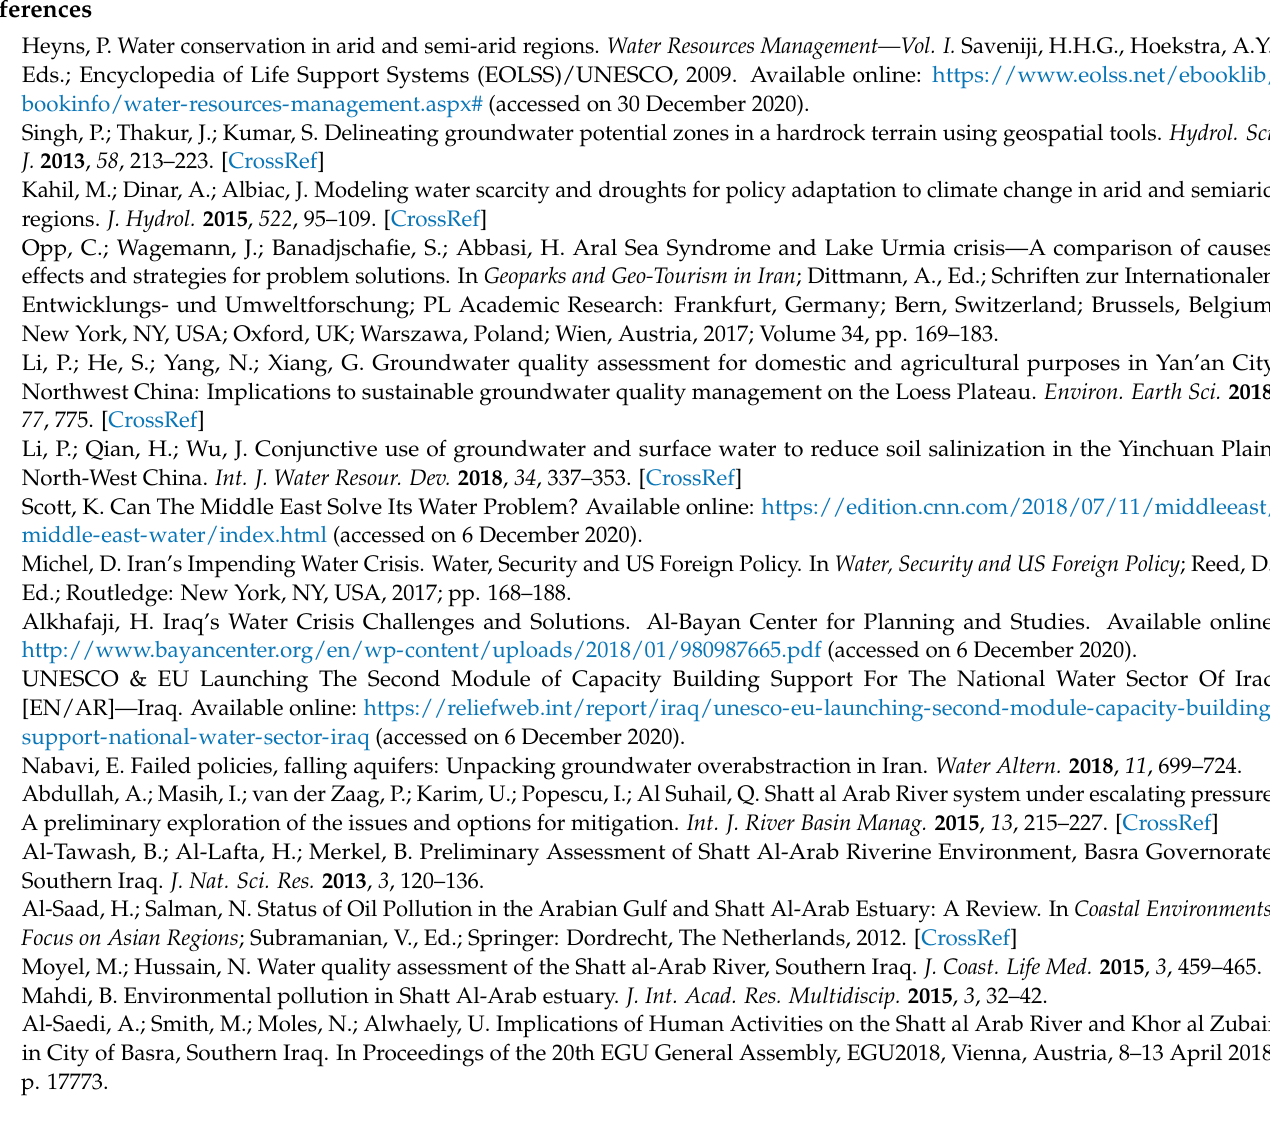
the study area, Figure S5: Slope of the study area, Figure S6: Drainage density of the study area, Figure S7: Distance to rivers of the study area, Figure S8: Soils (dominant grain sizes) of the study area, Figure S9: LULC of the study area, Figure S10: Lineament density of the study area, Table S1: Accuracy assessment of GWPZs map with average groundwater water